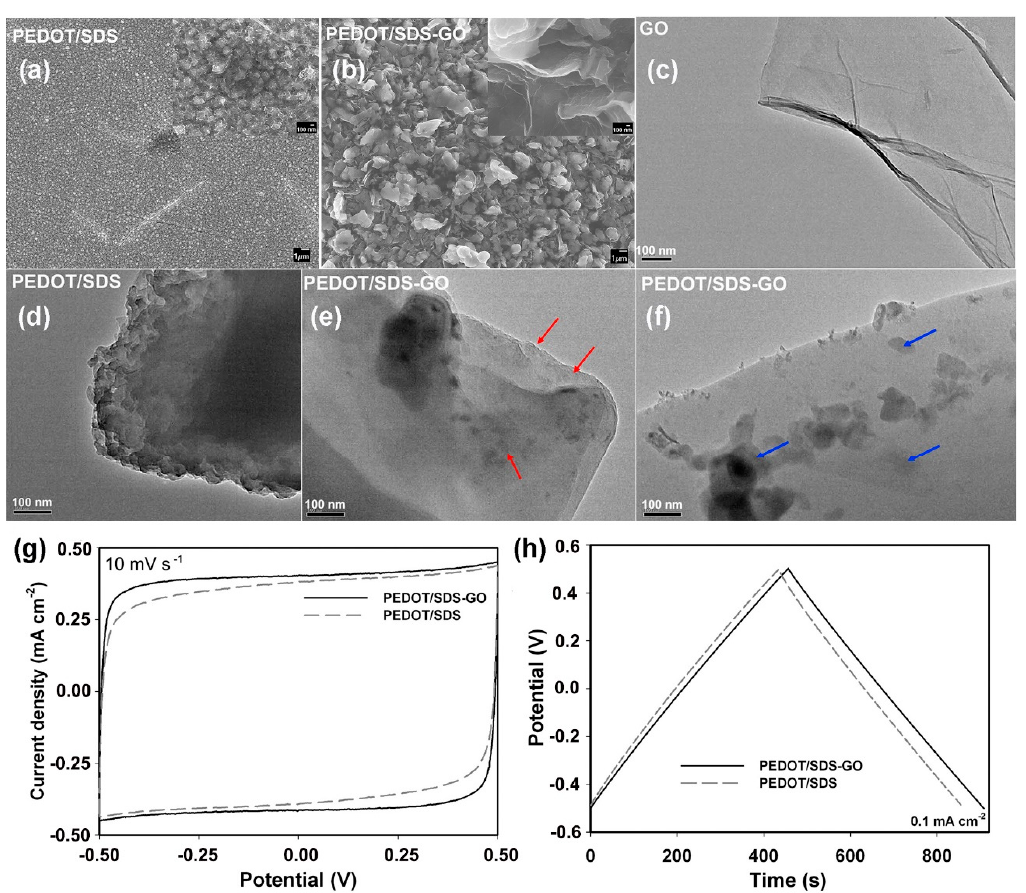
Figure 8. SEM images of PEDOT/SDS ( a ) and PEDOT/SDS-GO ( b ) composite films; TEM images of GO ( c ), PEDOT/SDS ( d ), and PEDOT/SDS-GO composites ( e ), ( f ). Reproduced with permission from [86]. Elsevier (2018).